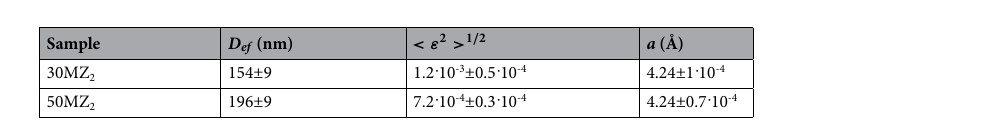
Figure 6. XRD experimental data with Rietveld refinement of ( a) 30MZ 2 and ( b ) 50MZ 2 after thermal treatment at 1400 °C under nitrogen flow.